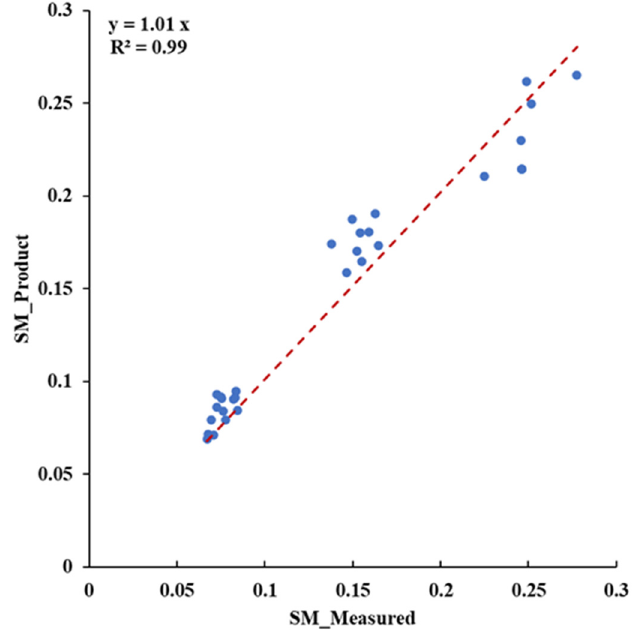
Figure 6. Reliability evaluation of soil moisture data.